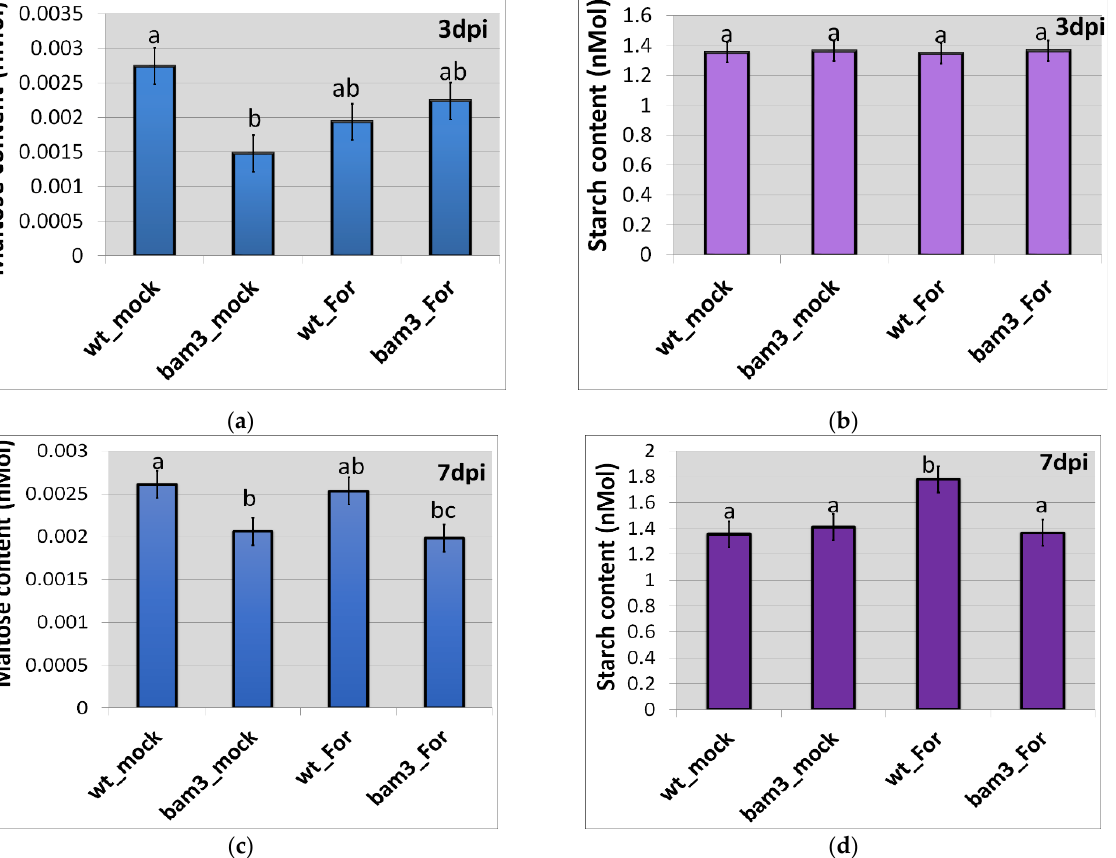
Figure 3. Quantification of maltose ( a , c ) and starch ( b , d ) content in the tissues of mock and inocu- lated with Fusarium oxysporum f. sp. raphani ( For ) Arabidopsis thaliana wt and bam3 plants at three and seven dpi. Data are presented as means ± standard error (SE) of three independent biological replicates, with two technical replicates each. Different letters on columns indicate significant differences according to ANOVA and Fisher’s LSD multiple-range test at p ≤ 0.05.